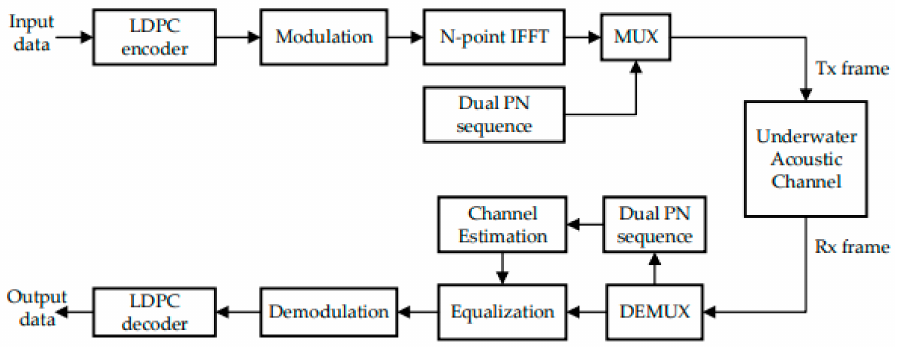
Figure 9. TDS-OFDM for the UWA channel